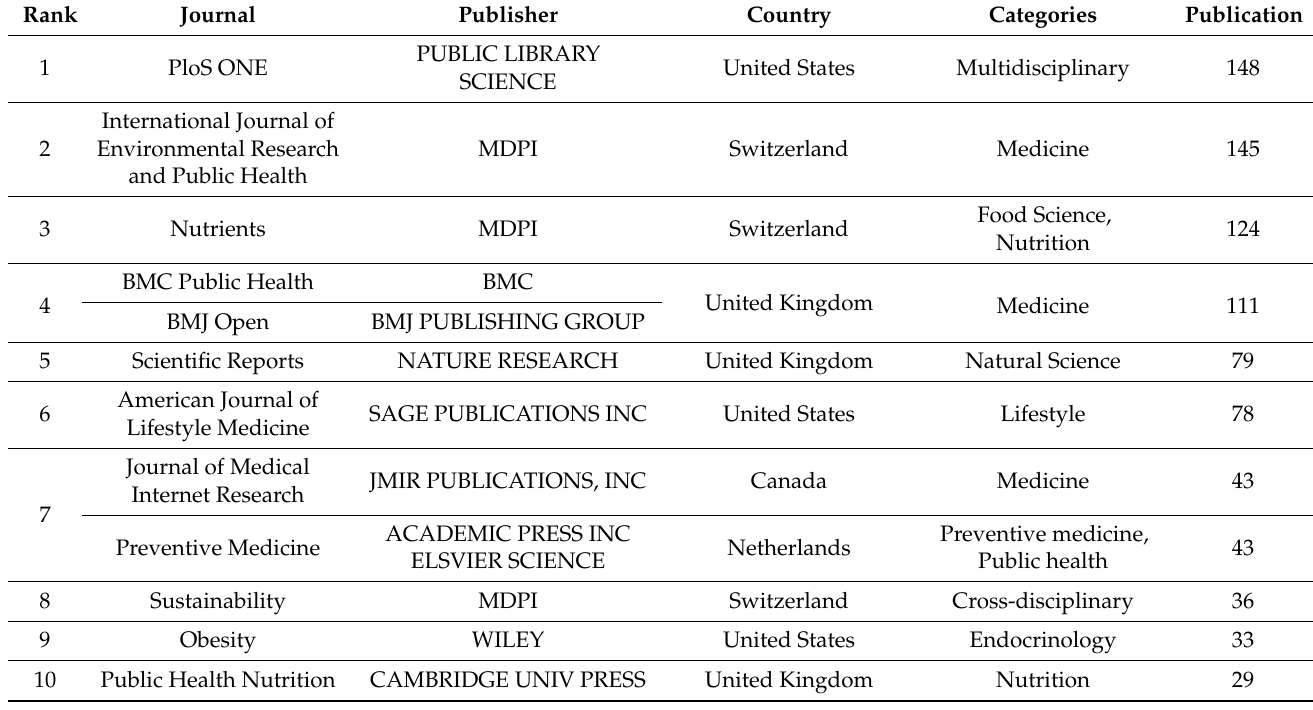
Table 1. Top 10 journals publishing research on lifestyle research,